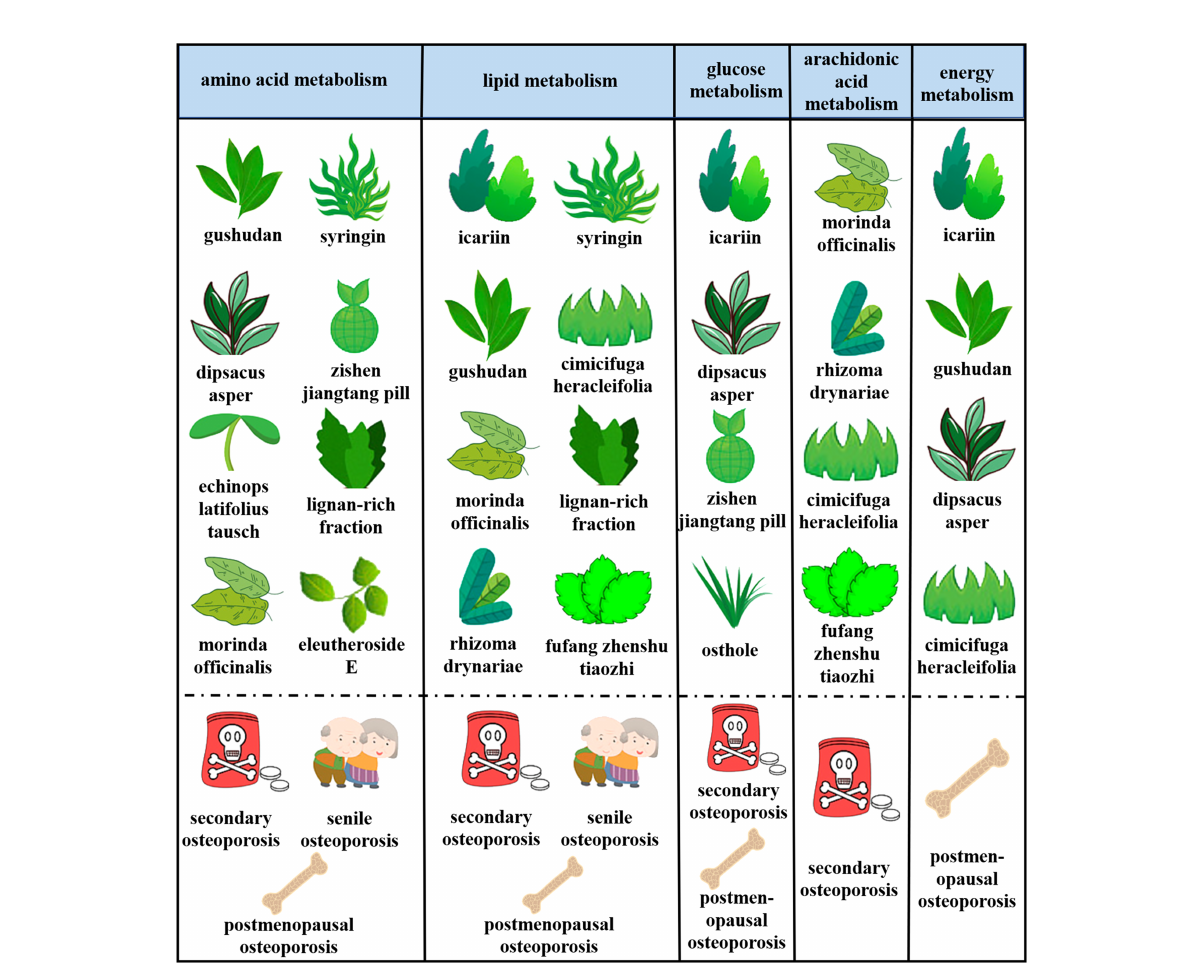
FIGURE 2 Metabolic pathways of different types of natural herbal action and therapeutic effects on different types of